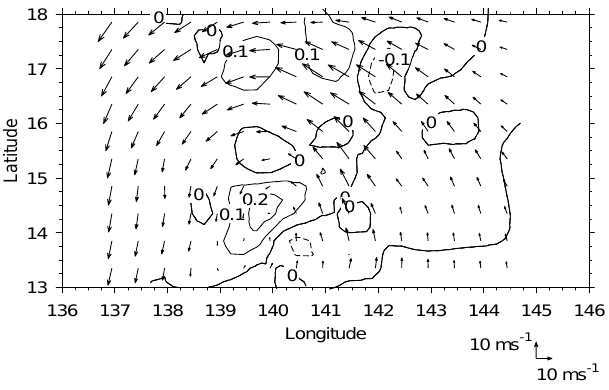
Fig. 9. Same as Fig. 8, but contours show vertical velocity every 0.1 ms − 1 .